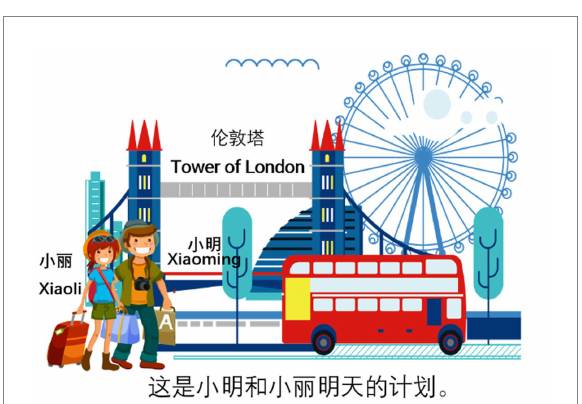
FIGURE 2 Picture and contextual information for (11).